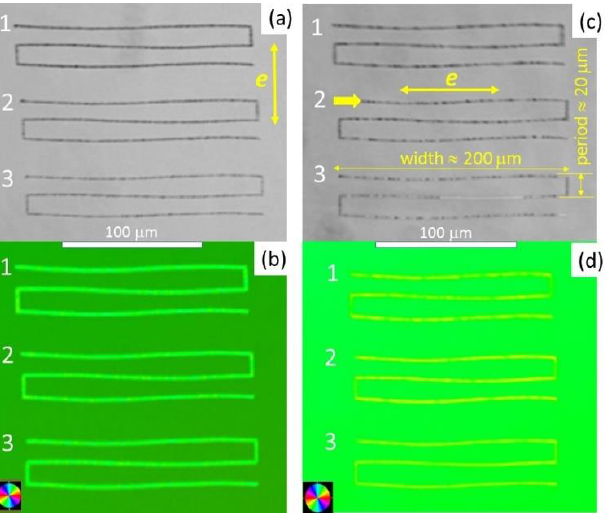
Figure 2. (top) Optical images of typical 3-line 200- μm wide structures (period - 20 μm) inscribed in nanoporous fused silica at a depth of 50-micron, at 1030-nm ( a ) and 515-nm ( c ) wavelengths; 0.3-ps laser pulsewidths; and 0.045 (1), 0.038 (2), 0.033 (3) and 0.11 (1), 0.10 (2), and 0.09 (3) μ J energy levels, respectively. The large yellow arrows indicate the laser polarization direction. (bottom) Their corresponding polarimetric (Abrio) pseudocolor images ( b,d ), where the color of the lines shows their “slow” axis direction according to the color maps.